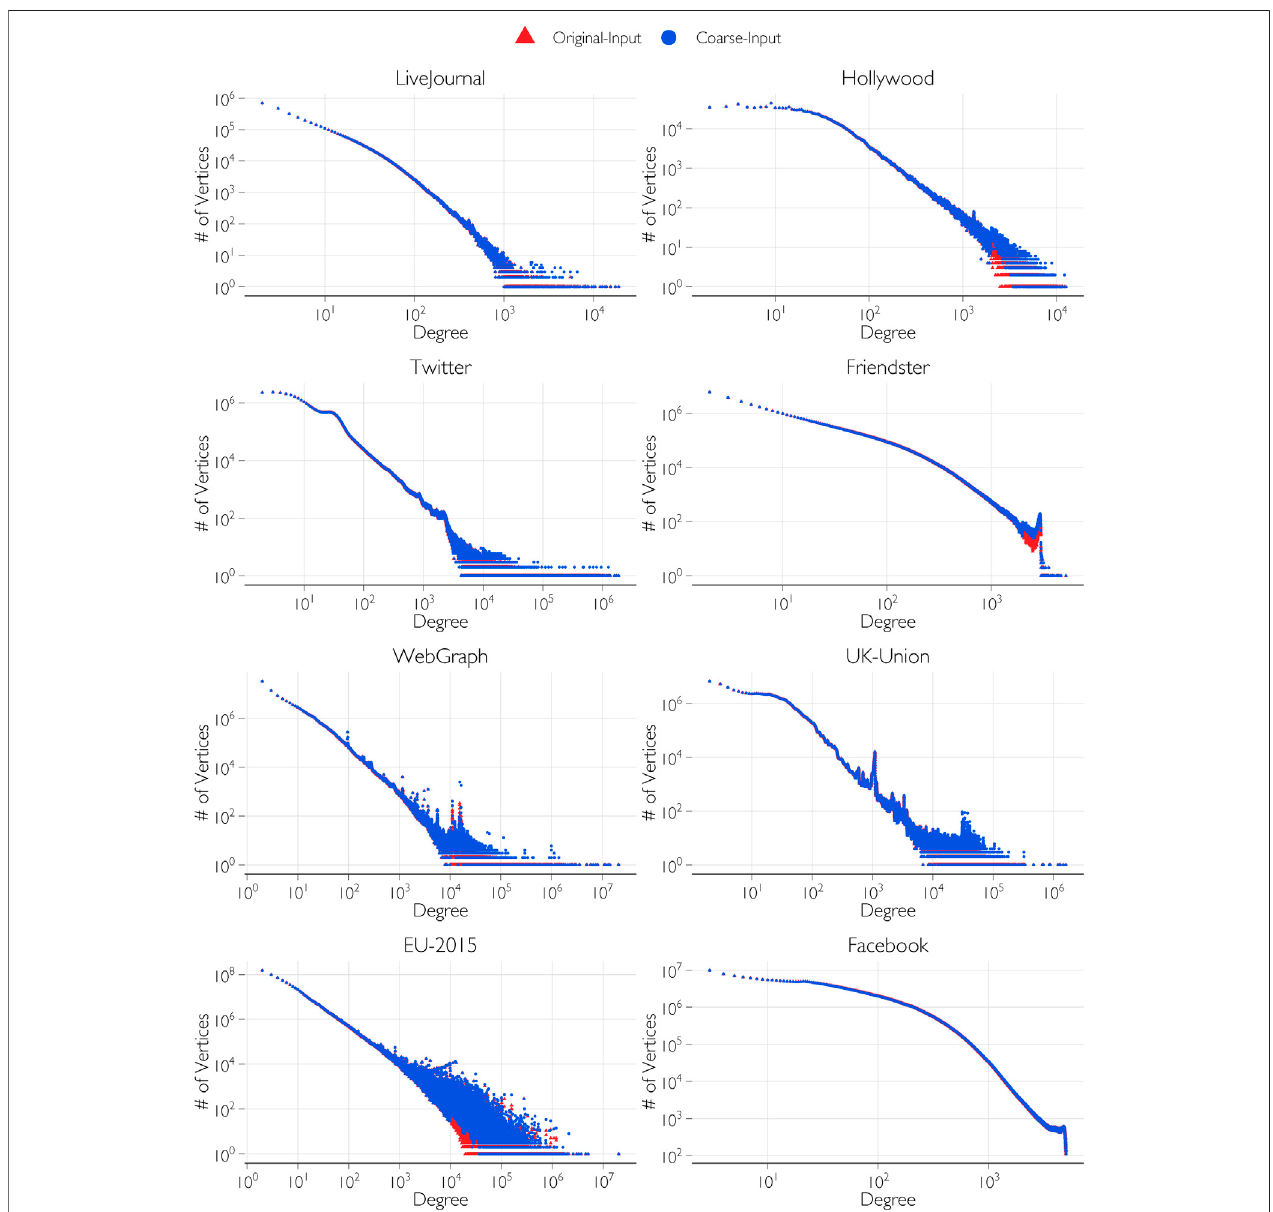
FIGURE 6 | Comparison of the original input degree distributions and coarsened input degree distributions.